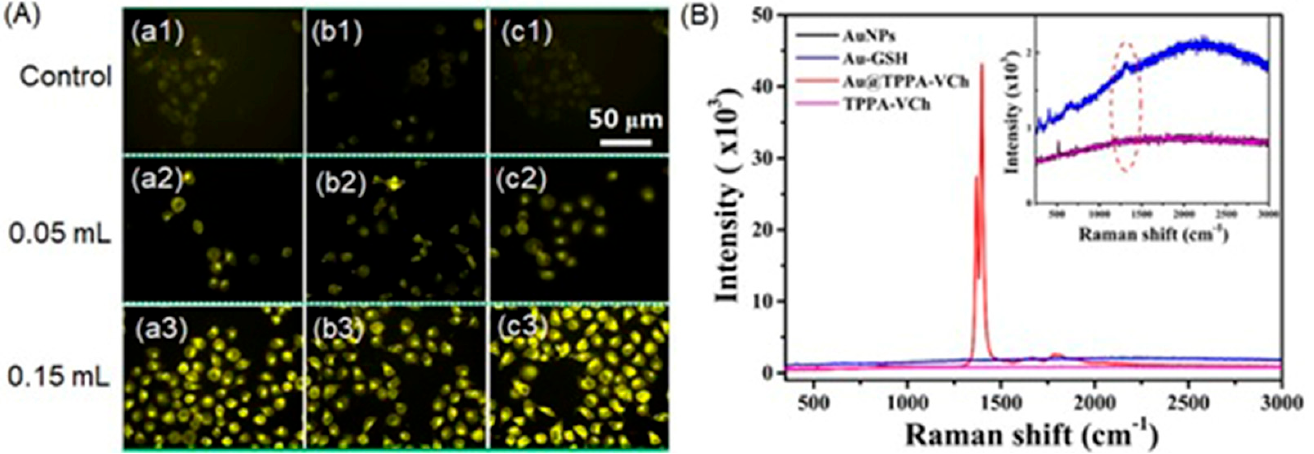
Figure 36. ( A ) Fluorescence images of parallel samples (a, b, and c) of HepG2 cells incubated with functionalized gold nanoparticles (10 μ g mL –1 ) for 20 min. Excitation and emission wavelengths are 438 and 613 nm, respectively, in different volumes of glutathione. ( B ) SERS intensity of gold nanoparticles (AuNPs), immunoassay probe (TPPA-VCh), functionalized gold nanoparticle with immunoassay probe (Au@TPPA-VCh), and gold nanoparticles functionalized with glutathione (Au@GSH). The inset shows the enlarged spectra of AuNPs, AuGSH, and TPPA-VCh, Excitation wavelength = 438 nm; exposure time = 10 s. Adapted from Spectrochimica Acta Part A: Molecular and Biomolecular Spectroscopy , 223 , Yao, W.; Chang, L.; Yin, W.; Wang, T.; Yang, Y.; Yin, P.; Yang, M.; Ma, Y.; Qin, Y.; Ma, H. One immunoassay probe makes SERS and fluorescence two readout signals: Rapid imaging and determination of intracellular glutathione levels, 117303, Copyright 2019, with permission from Elsevier [340].